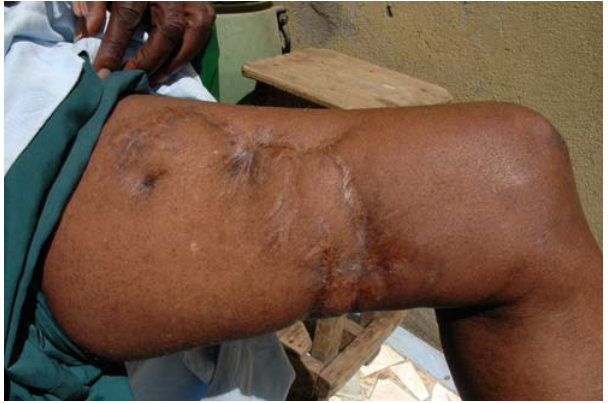
Figure 2. The thigh of a Senegalese fisherman forty years after a shark